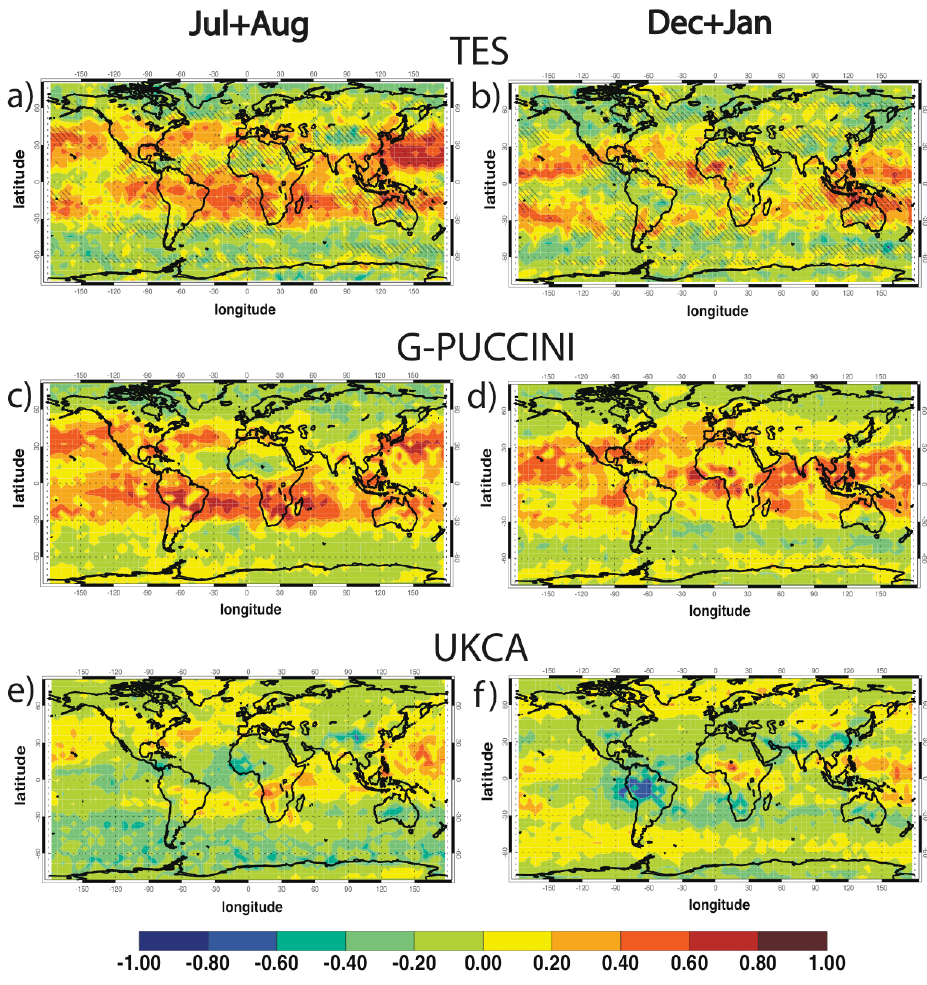
Fig. 3. Correlation coefficient of daily mean 2005–08 middle/lower free tropospheric O 3 and CO concentrations for TES (a, b) , G-PUCCINI (c, d) and UKCA (e, f) in July–August (left panels) and December–January (right panels). We used data from 7 TES pressure levels between 800 and 400hPa. TES sampling and operators have been applied to the model output. Also, the observational error has been taken into account for the model correlations, following Eq. (3) of Zhang et al. (2006). Stippling indicates the areas for which less than 40 sample members (i.e. days) were available for the correlation calculation. These are the same (but not shown) in the middle and lower panels (c, d, e, f) , since the geographical and temporal sampling was identical with the upper panels. Within these regions with > 40 sample members, correlations are statistically significant only where they are higher than 0.3 or lower than − 0.3, based on a Pearsons test (95% confidence interval). The data have been smoothed by averaging on a 4 × 5 degree